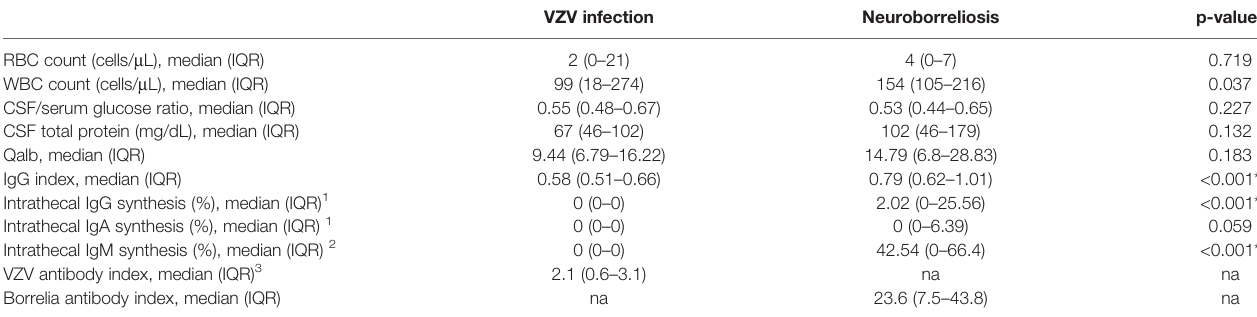
TABLE 2 | Cerebrospinal fl uid characteristics of patients with varicella zoster virus infection and neuroborreliosis.